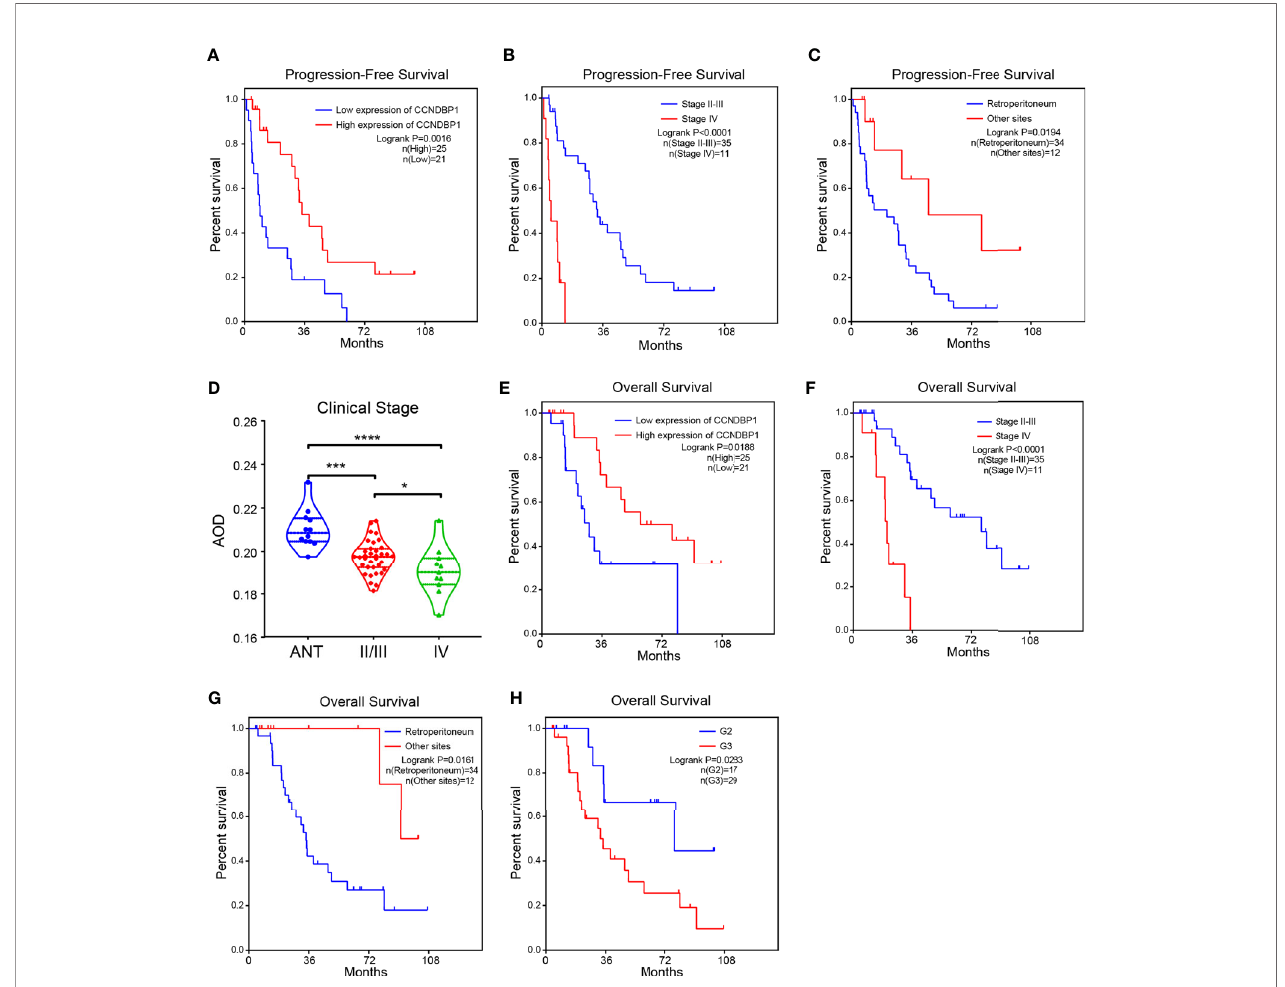
FIGURE 3 | The higher the expression of CCNDBP1, the better the prognosis of patients. (A) In fl uence of CCNDBP1 protein expression level on the PFS of patients. The AOD value of 0.1950 as the boundary, the higher the CCNDBP1 protein expression level, the longer the PFS; (B) In fl uence of clinical staging on the PFS of patients. The later the clinical staging, the shorter the PFS; (C) In fl uence of tumor sites on the PFS of patients. The PFS of tumors located in the retroperitoneum is shorter than that of the other sites; (D) Relationship between CCNDBP1 protein expression level and the clinical staging of patients; the later the clinical staging level, the lower the CCNDBP1 protein expression level, and the protein expression of CCNDBP1 in ANT was signi fi cantly higher than that in sarcoma tissues; (E) In fl uence of CCNDBP1 protein expression level on the OS of patients; the higher the CCNDBP1 protein expression level, the longer the OS; (F) In fl uence of clinical staging on the OS of patients; the later the clinical staging level, the shorter the OS; (G) In fl uence of tumor sites on the OS of patients. The OS of tumors located in the retroperitoneum is shorter than that of the other sites; (H) In fl uence of histopathological grading on the OS of patients; the higher the histopathological grade, the shorter the OS. ANT, adjacent normal tissue; *P < 0.05; ***P < 0.001; ****P <